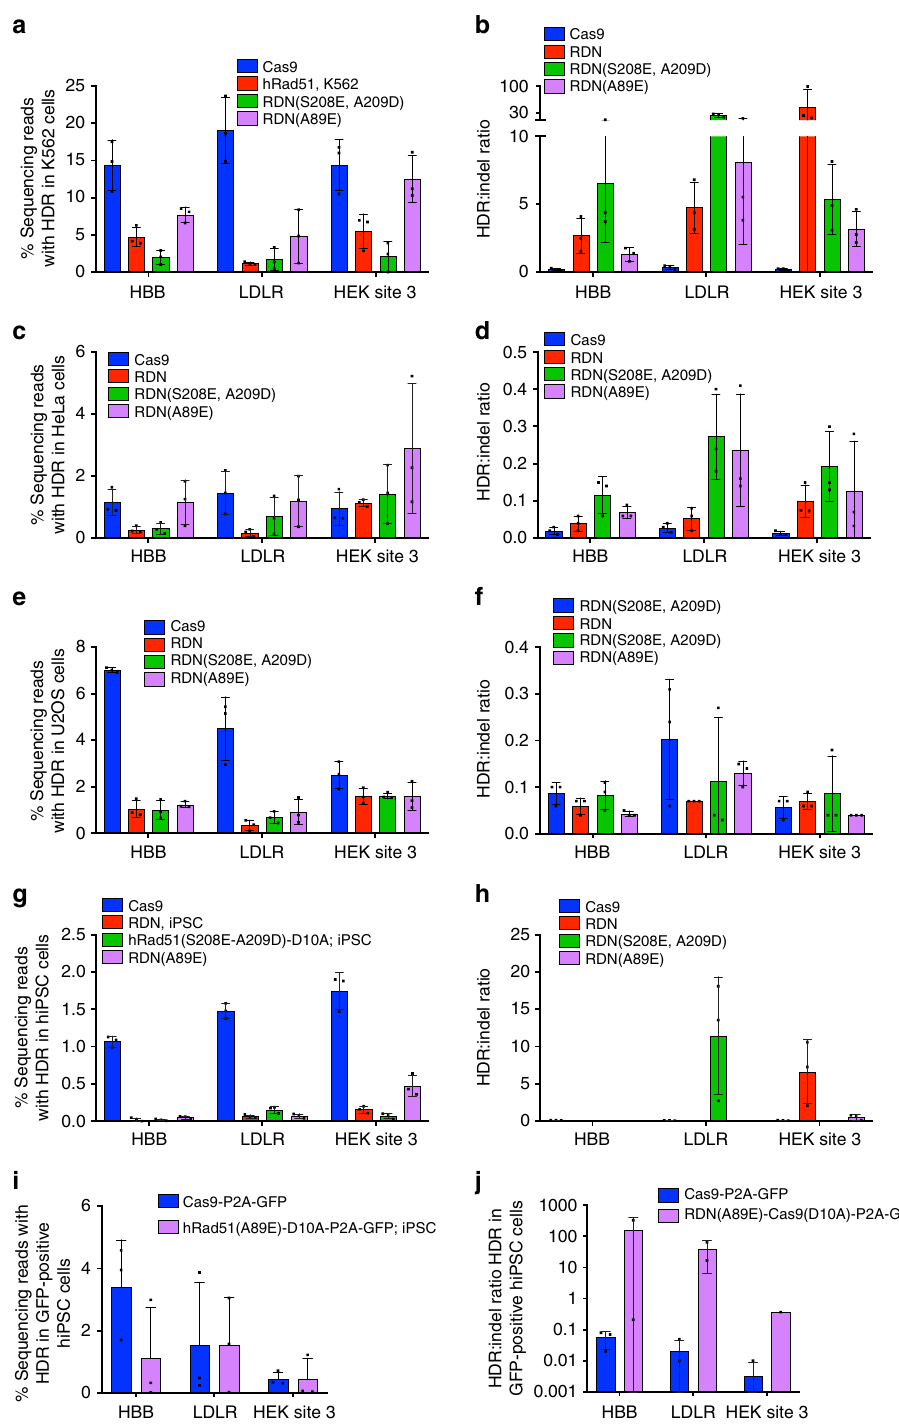
Fig. 5 hRad51 – Cas9(D10A) nickase activity in K562, U2OS, HeLa and hiPS cells. a , c , e , g HDR frequencies, measured by high-throughput sequencing in unsorted, nucleofected cells at three loci; b , d , f , h HDR:indel ratio associated with editing at the same three loci. i , j HDR frequency and HDR:indel ratios in iPS cells nucleofected with P2A-GFP tagged constructs and sorted for GFP-positive cells. All data are shown as individual data points and mean ± s.d. for n = 3 biological replicates, performed independently. An HDR:indel ratio was not reported if the HDR frequency was <0.1% (see Methods section). Source data are provided in the Source Data fi